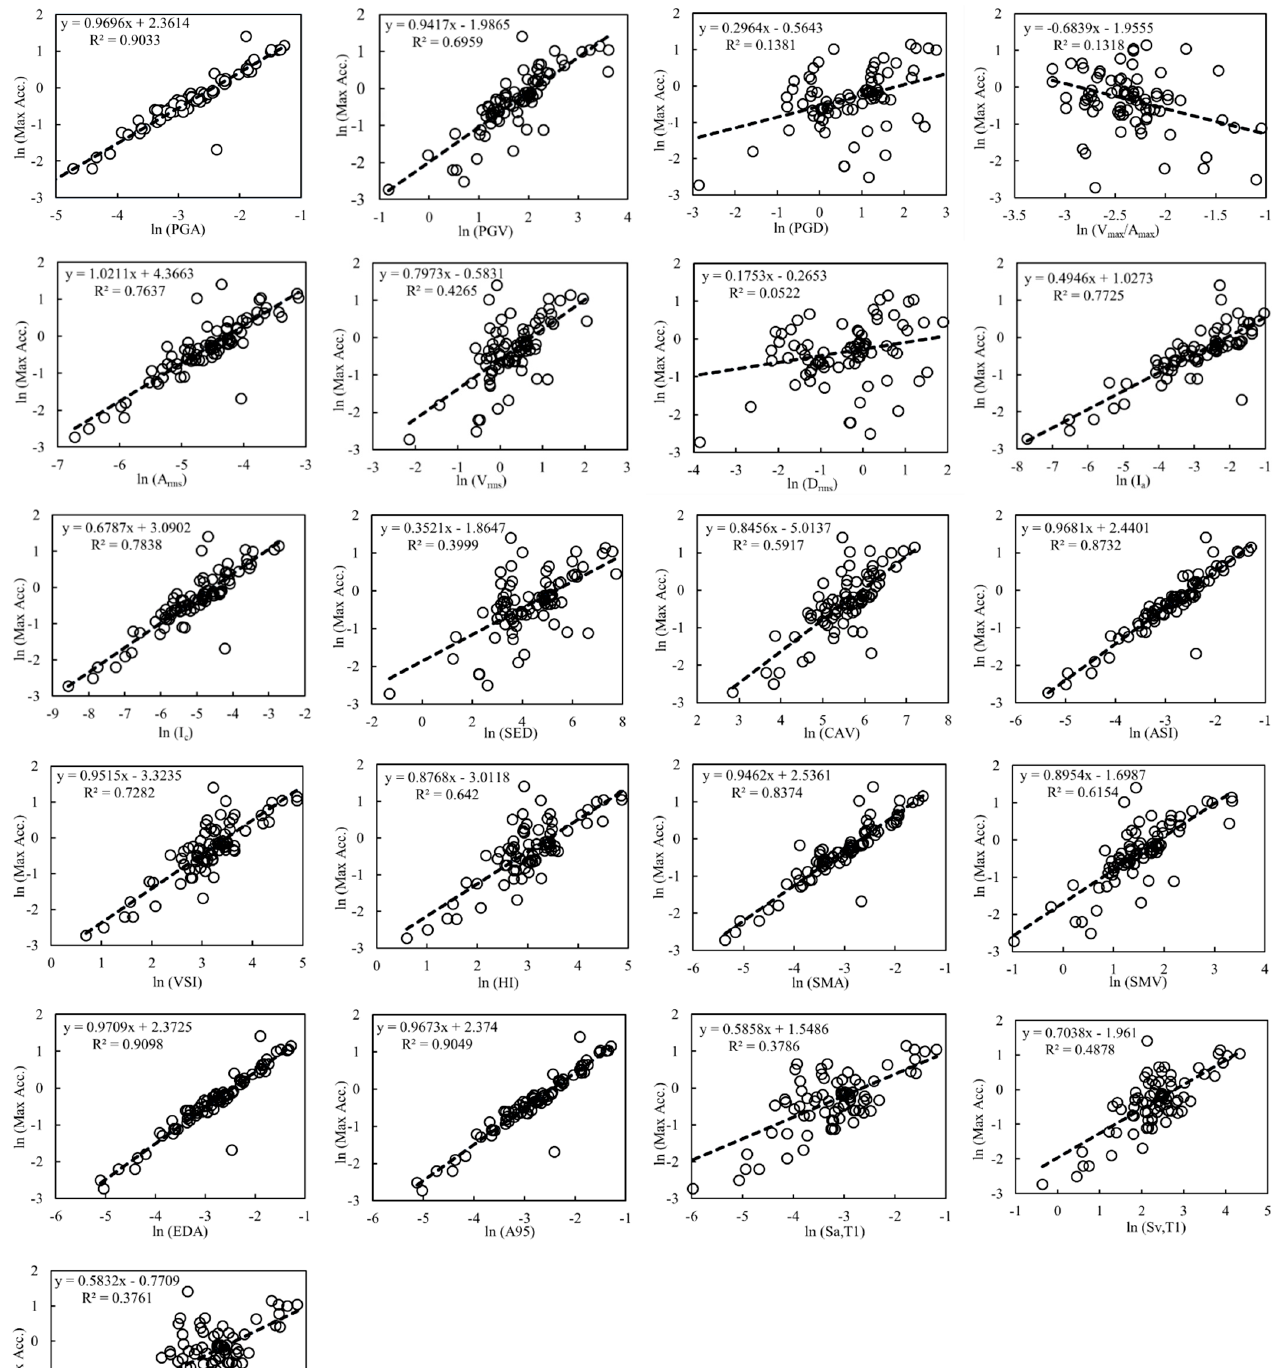
Figure 10. Linear regression of PSDMs for various IMs considering maximum acceleration as EDP.